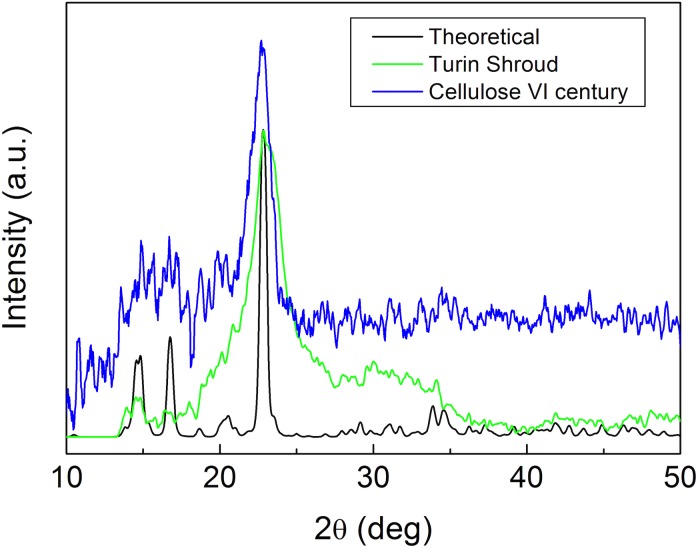
WAXS pattern.Azimuthally integrated experimental WAXS pattern (green curve) compared to the cellulose theoretical diffraction pattern (black curve). For comparison, cellulose WAXS pattern was collected also on fibers of the VI century (blue profile), sample D in reference [10].